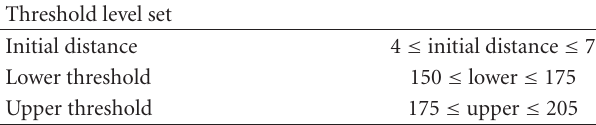
Table 2: Internal constraints for threshold level